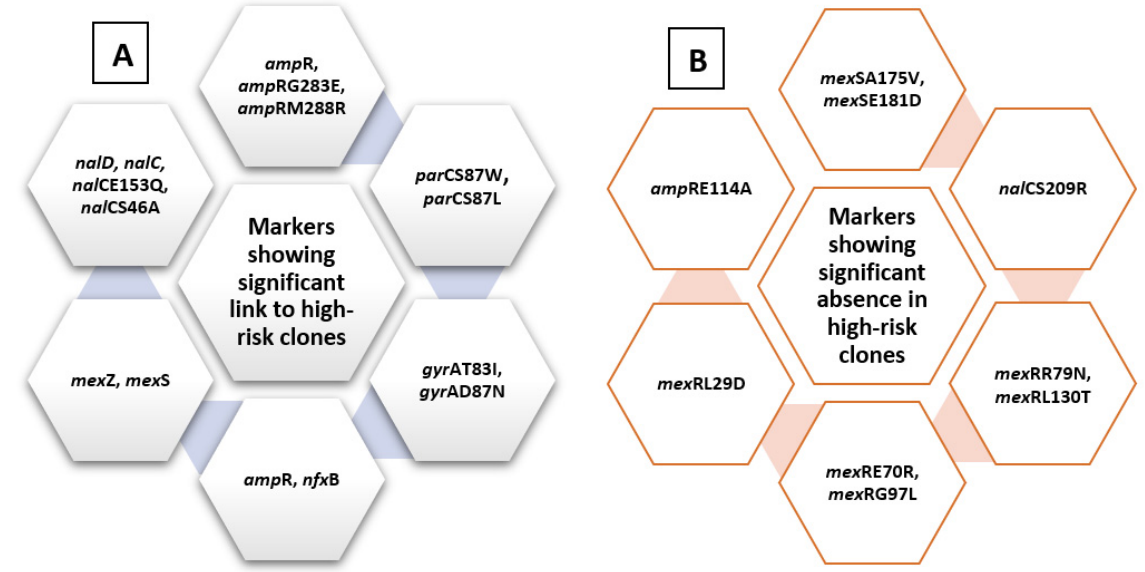
Figure 4. Summary diagram showing levofloxacin-related molecular markers. The figure summarizes markers showing significant presence in high-risk clones ( A ) and those showing significant absence in relation to high-risk clones ( B ).